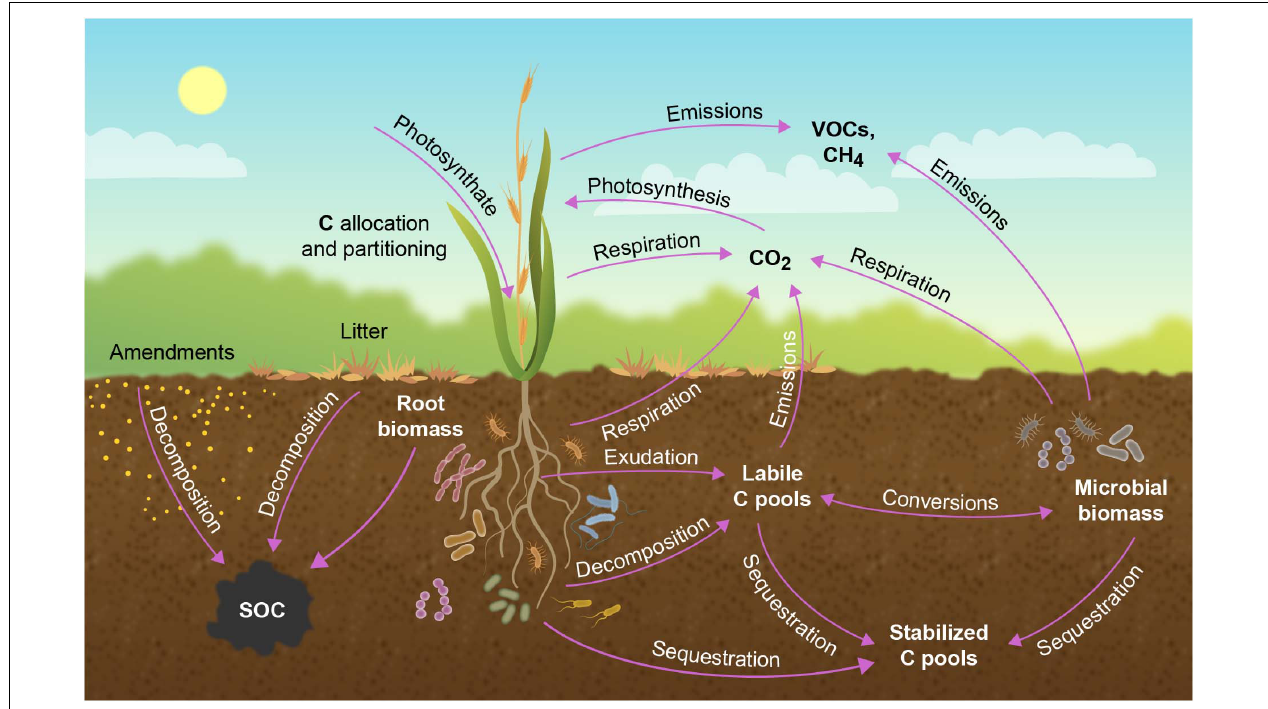
FIGURE 2 | Transfer of atmospheric CO 2 into biotic and pedologic carbon (C) pools the plant ecosystem. Carbon enters the soil as root exudates or via decomposition of root or aboveground biomass. In the soil, C exists in root or microbial biomass, as bioavailable labile organic C, or as more recalcitrant C. Carbon exits the soil as direct emissions, or via root or microbial respiration, with microbial-mediated soil respiration being the major source of CO 2 from terrestrial ecosystems. Carbon is also lost from the ecosystem as volatile organic compounds (VOCs) and methane (CH 4 ). Modified from Jansson et al.